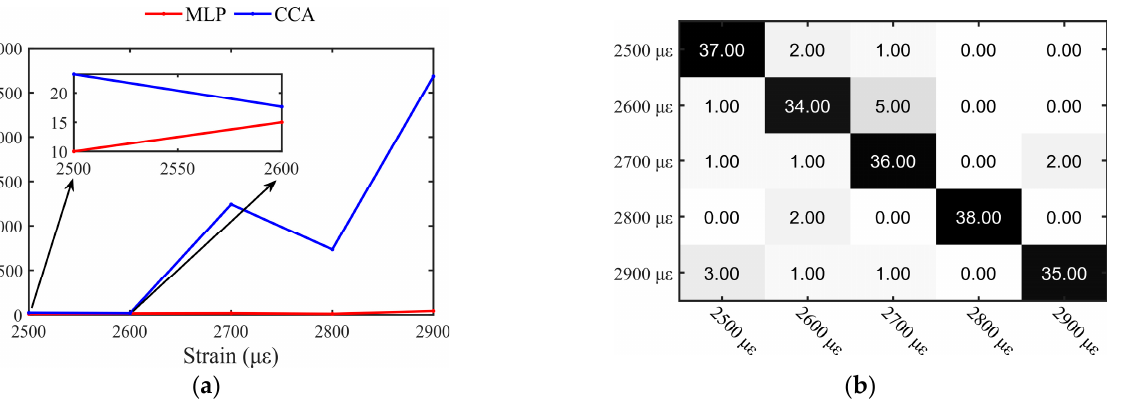
Figure 11. ( a ) Mean absolute error of multilayer perceptron and cross-correlation algorithm at strain from 2500 to 2900 µε ; ( b ) confusion matrix of multilayer perceptron.